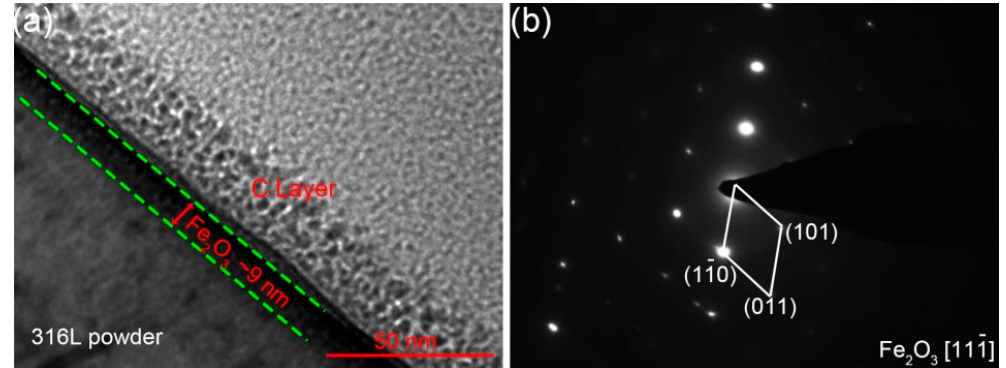
Figure 6. Transmission electron microscopy (TEM) analysis of the oxide layer in 316L powder: ( a ) TEM-BF image of surface structure and ( b ) selected area electron diffraction (SAED) result of Fe 2 O 3 .